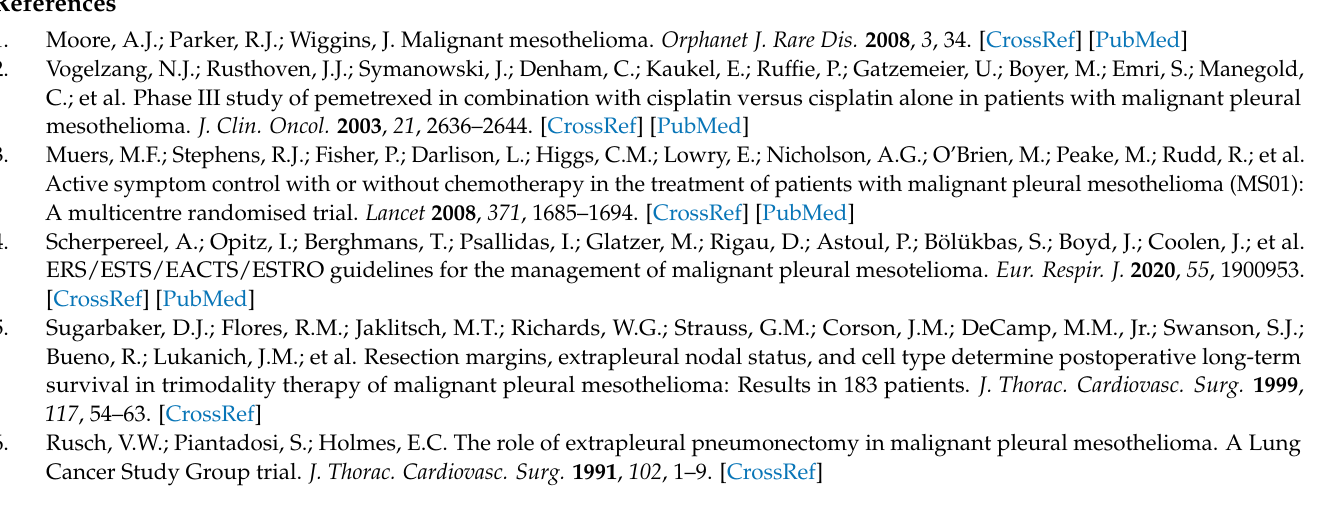
Figure S3. Graph of FEV1 at baseline, 3 months, and 6 months after radiotherapy. Figure S4. (A) Graph of Time to Progression of all patients; (B) Graph of time To Progression of operated patients and no-operated